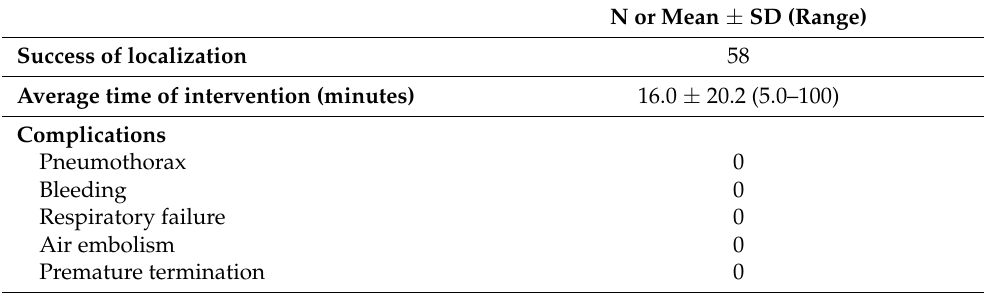
Table 2. Procedural outcomes.